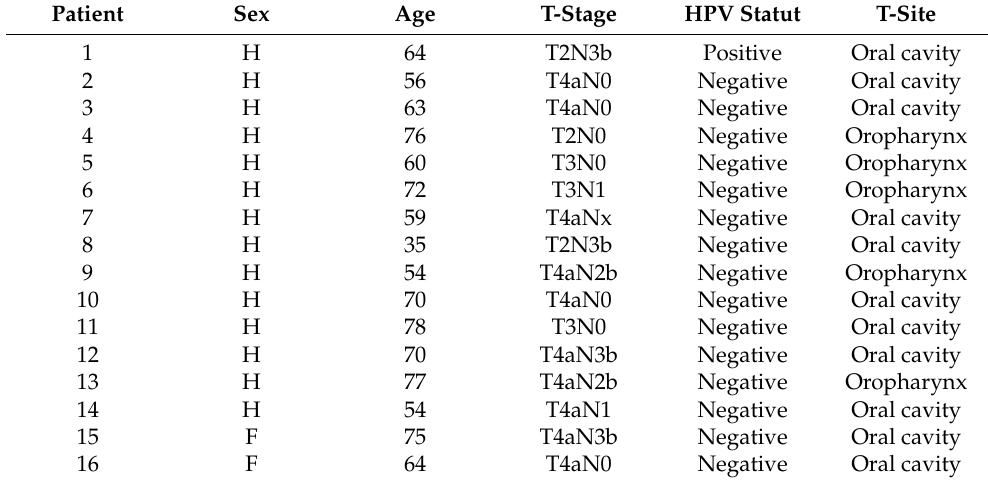
Table 1. Patient